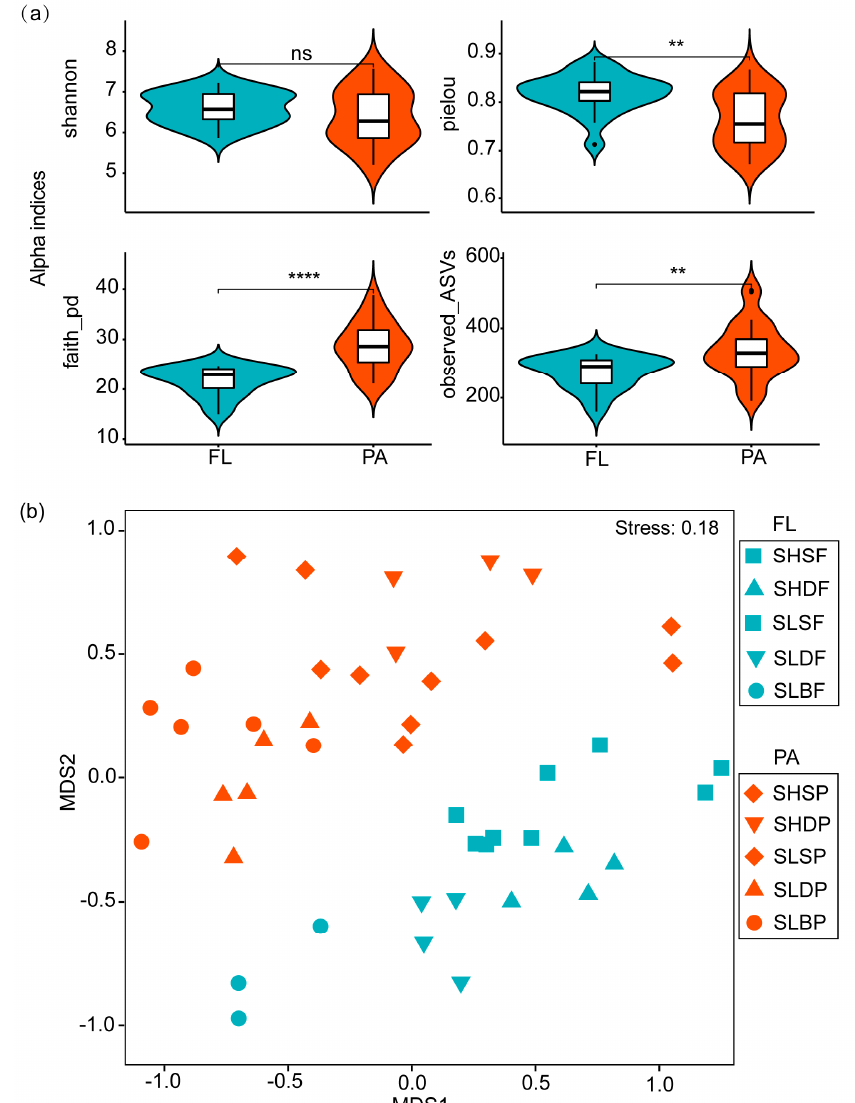
Figure 2. ( a ) Differences in alpha diversity between FL and PA communities. One-side significance based on bootstrapping test was expressed as **** p < 0.001; ** p < 0.05; ns > 0.05. ( b ) Two-dimensional NMDS ordination using Bray–Curtis indices of bacterioplankton communities. The samples were collected in June 2016 in MACRO cruise, and samples grouped by two size fractions (free living and particle associated), different stations (Slope and Shelf) and depth (Surface, DCM and Bottom). Site names: SL = Slope, SH = Shelf, S = Surface, D = DCM, B = Bottom, F = fre -living and P = particle associated (Table S2). The numbers of replicated samples in this figure are as follows: In FL, SHSF ( n = 4), SHDF ( n = 4), SLSF ( n = 5), SLDF ( n = 4), SLBF ( n = 3); in PA, SHSP ( n = 4), SHDP ( n = 4), SLSP ( n = 6), SLDP ( n = 5), SLBP ( n = 6).